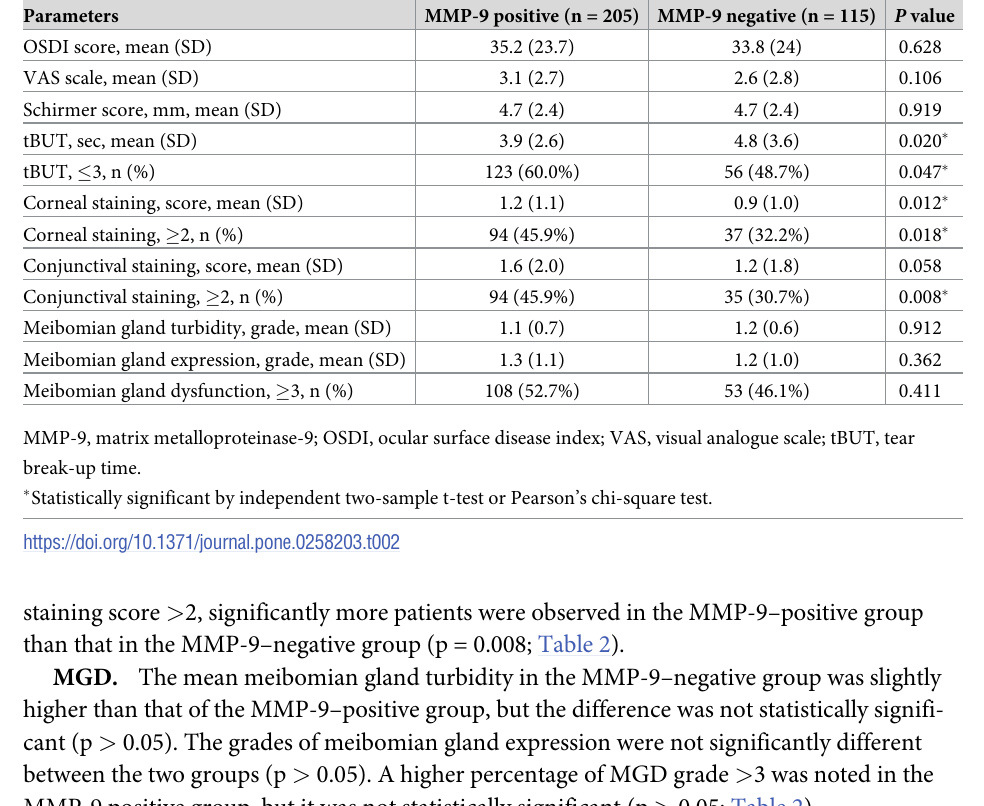
Table 2. Comparison of clinical signs and symptoms in MMP-9 positive versus negative patients. Parameters